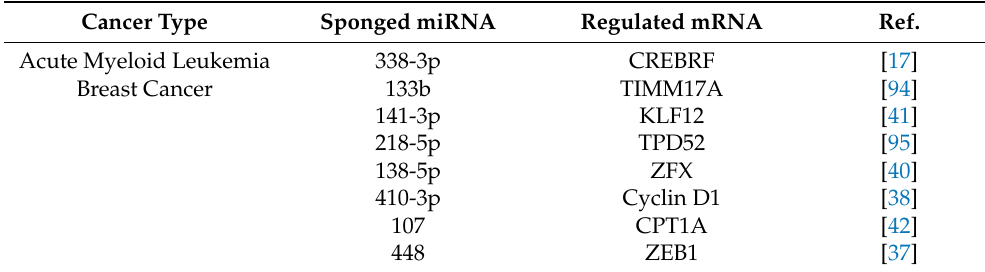
Table 1. NEAT1-miRNA-mRNA network involved in progression of cancer